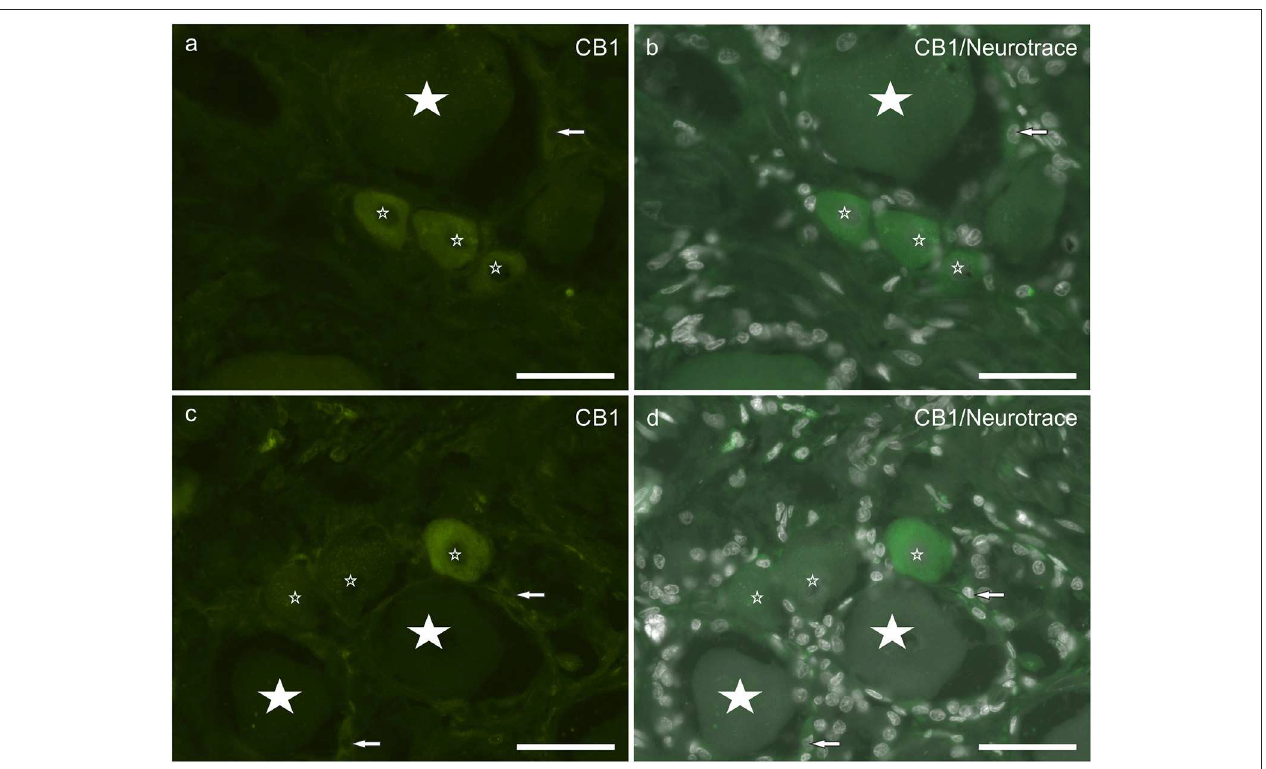
FIGURE 2 | (a–d) Photomicrographs of cryosections of canine cervical (C8) dorsal root ganglion showing cannabinoid receptor 1 (CB 1 ) immunoreactivity. Small stars indicate small neurons showing CB 1 receptor weak to moderate immunoreactivity. Large stars indicate CB 1 receptor negative. Arrows indicate satellite glial cells showing weak CB 1 receptor immunoreactivity. Bar: a–d = 50 µ m.